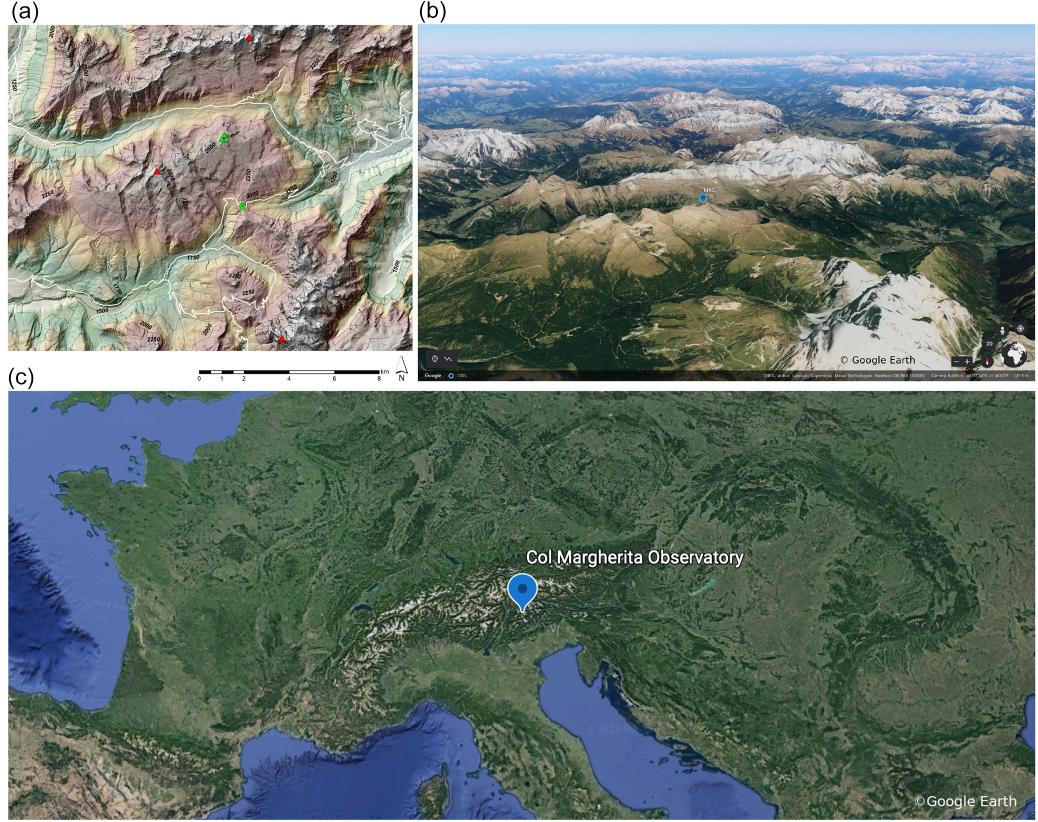
Figure 1. (a) Surrounding area of the Col Margherita Observatory (MRG; 46.36683 ◦ N, 11.79192 ◦ E; 2543ma.s.l.). Geographical key points and their distance from the MRG observatory are Passo Valles (SSE) at 2032ma.s.l. and 3.2km away, Cima Bocche (ESE) at 2745ma.s.l. and 3.3km away, Cima dell’Uomo (NNE) at 3010ma.s.l. and 4.6km away and Cimon della Pala (SSE) at 3184ma.s.l. and 9.3km away. (b) 3D aerial view of the Col Margherita (© Google Earth). (c) Satellite view of central Europe and the location of the Col Margherita Observatory (© Google